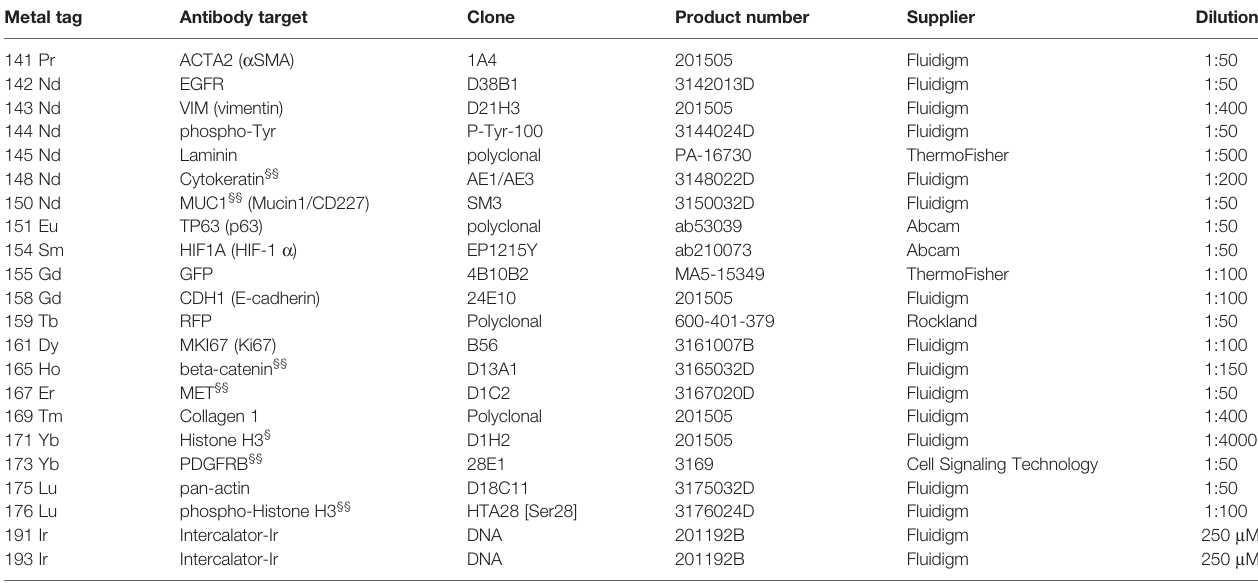
TABLE 3 | List of IMC